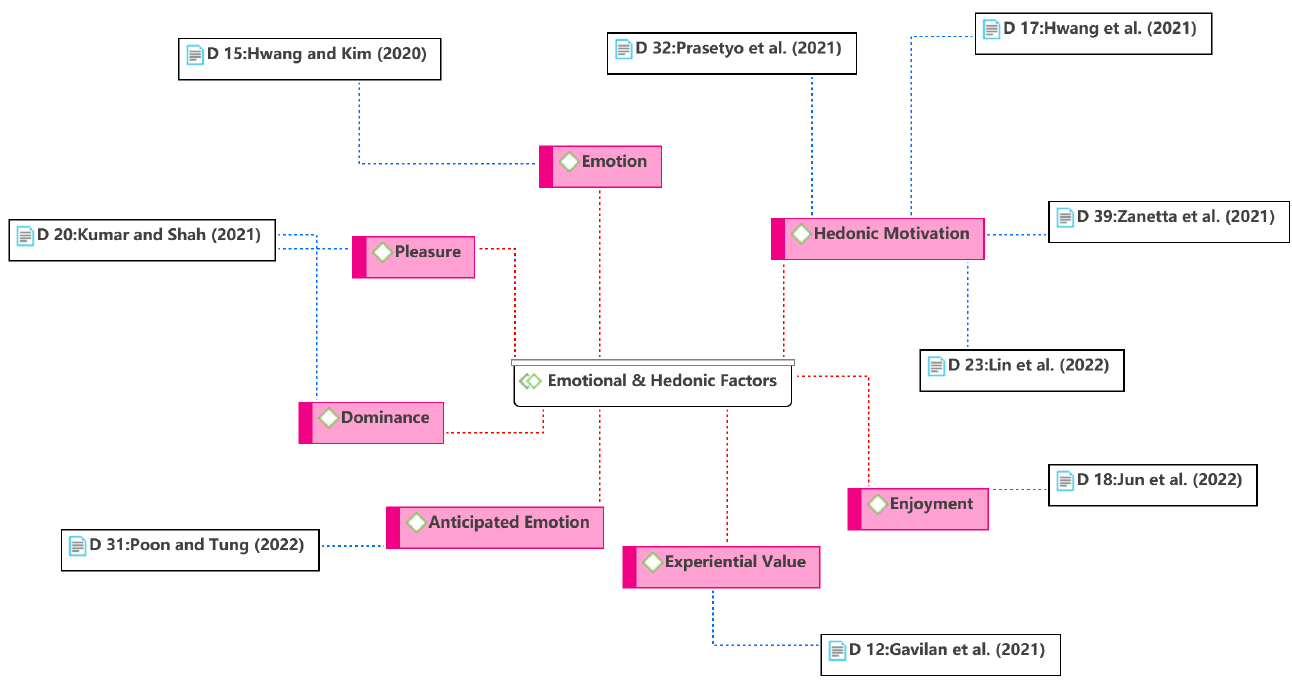
Figure 6. Theme 2: system-related attributes [7,12,27,35,44,46,49 – 51].